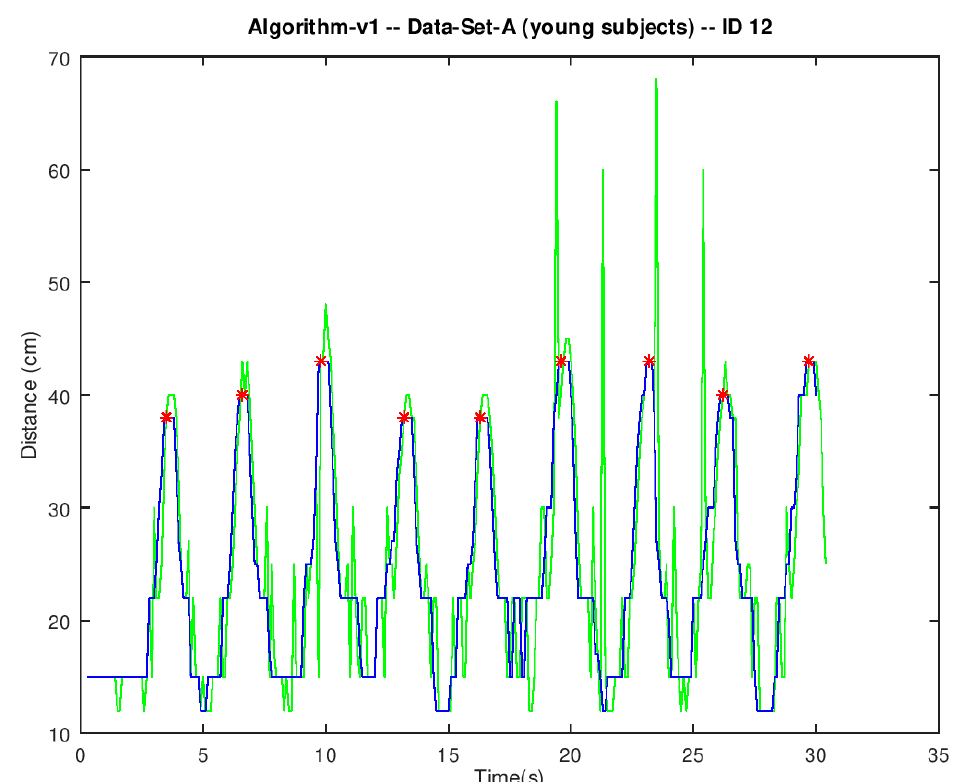
Figure 4. Graphical representation of a signal from dataset A (young healthy subjects) and the outcomes resulting from processing it with Algorithm-v1. The green line represents the pre-processed signal after removing all the outliers over a given threshold. The blue line represents the output of applying a moving median filter to the green signal. The red dots represent the sit-to-stand transitions identified and reported by the algorithm.